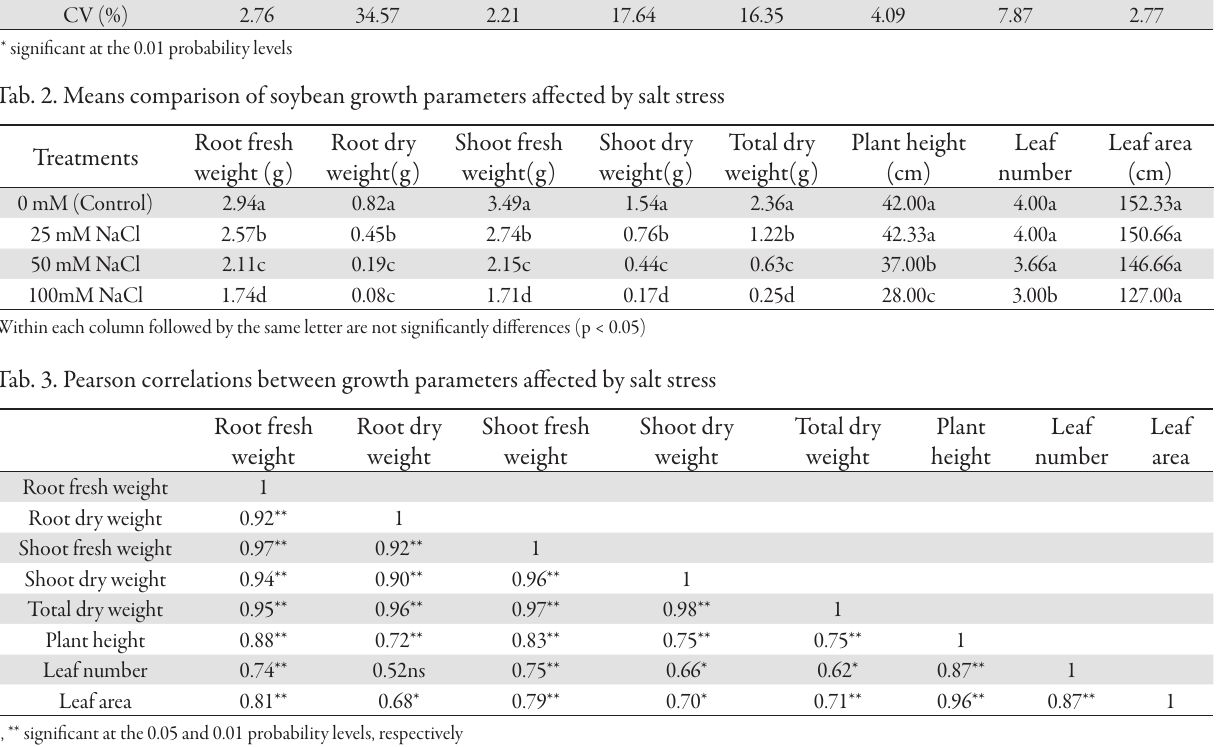
Tab. 1. Analysis of variance on soybean growth parameters affected by salt stress Sources of